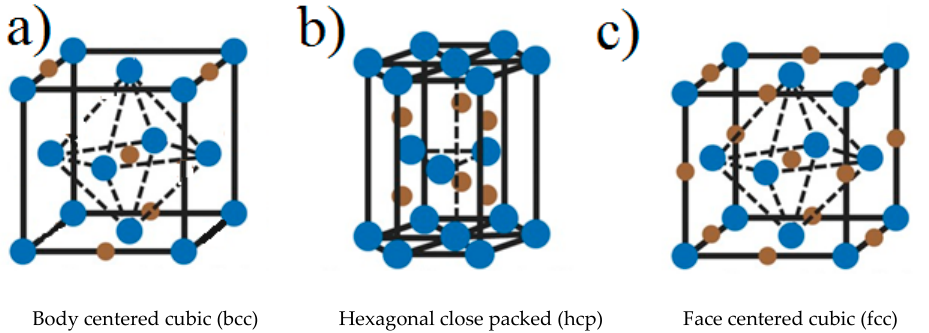
Figure 2. ( a ) bcc: TiN, ZrN, HfN, VN, CrN; ( b ) hcp: Mo 2 N, W 2 N; ( c ) fcc: MoN, TaN. Blue points represent transition metal atoms and brown points nitrogen atoms. Adapted from [6], with permission from Wiley, 2013.